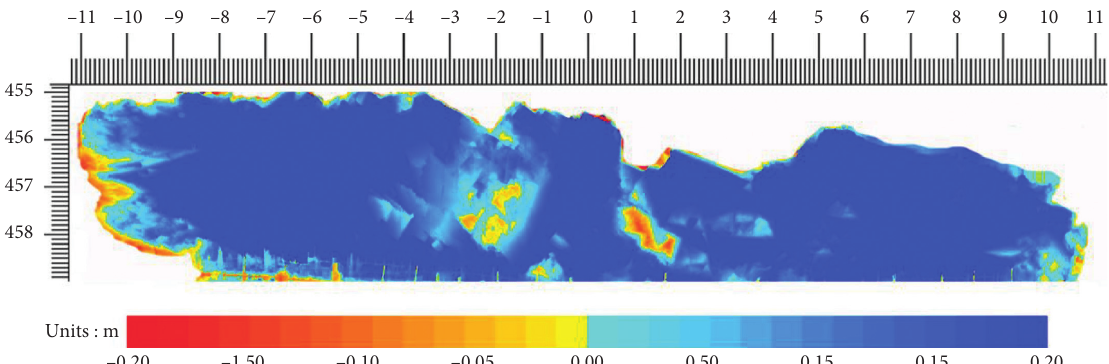
Figure 13: Expanded image of the tunnel overbreak and underbreak scanning.